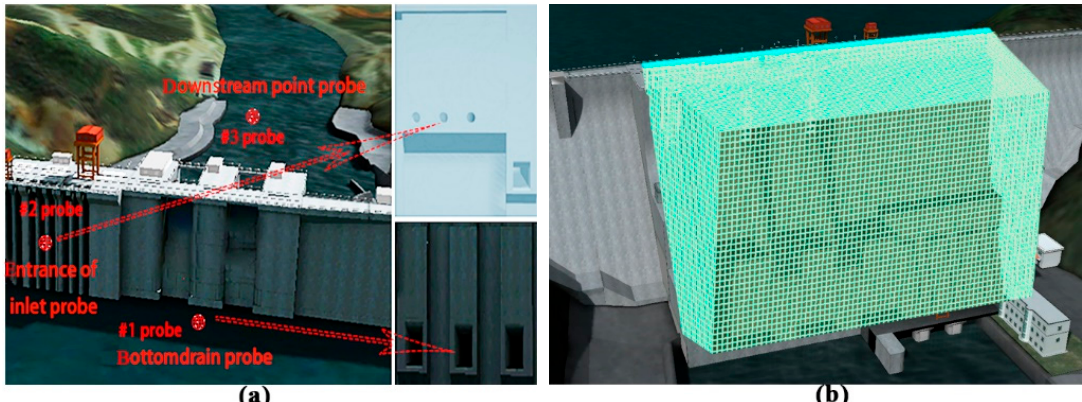
Figure 5. Initial condition configuration. ( a ) arrangement of probe points; ( b ) mesh of the partial computational domain.